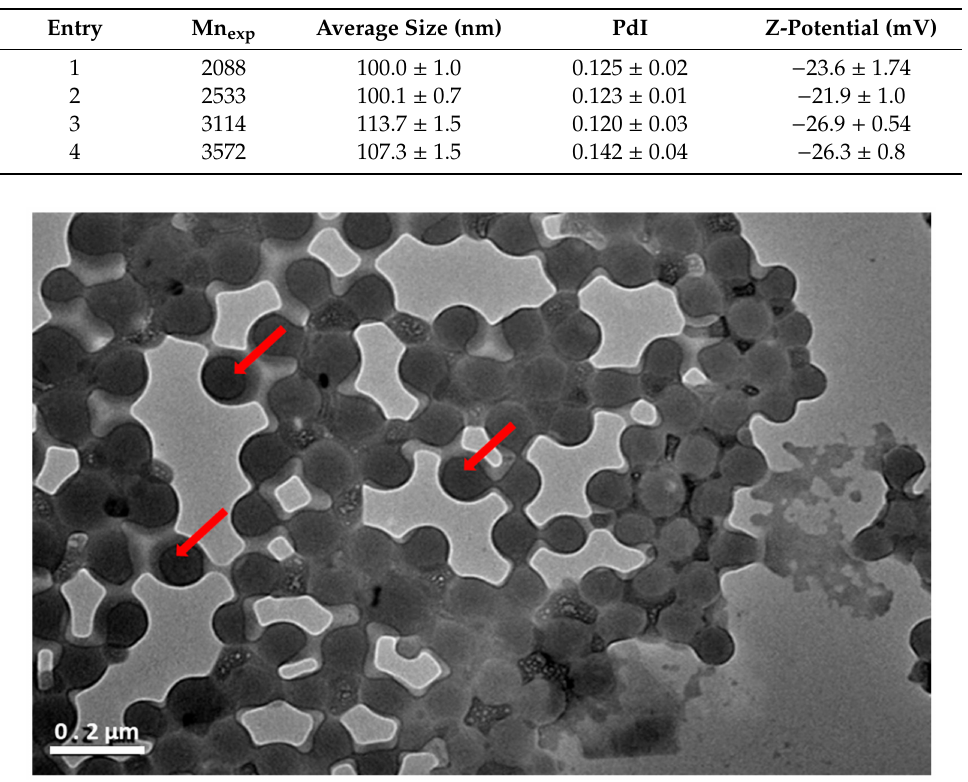
Figure 1. Transmission electron microscopy (TEM) images of CHO / PA NPs made from CHO / PA copolymer (Entry 3, Table 2). The TEM micrograph reveals that the nanoparticles surface is not perfectly flat as suggested by the combination of bright and dark (marked with arrows) contrast